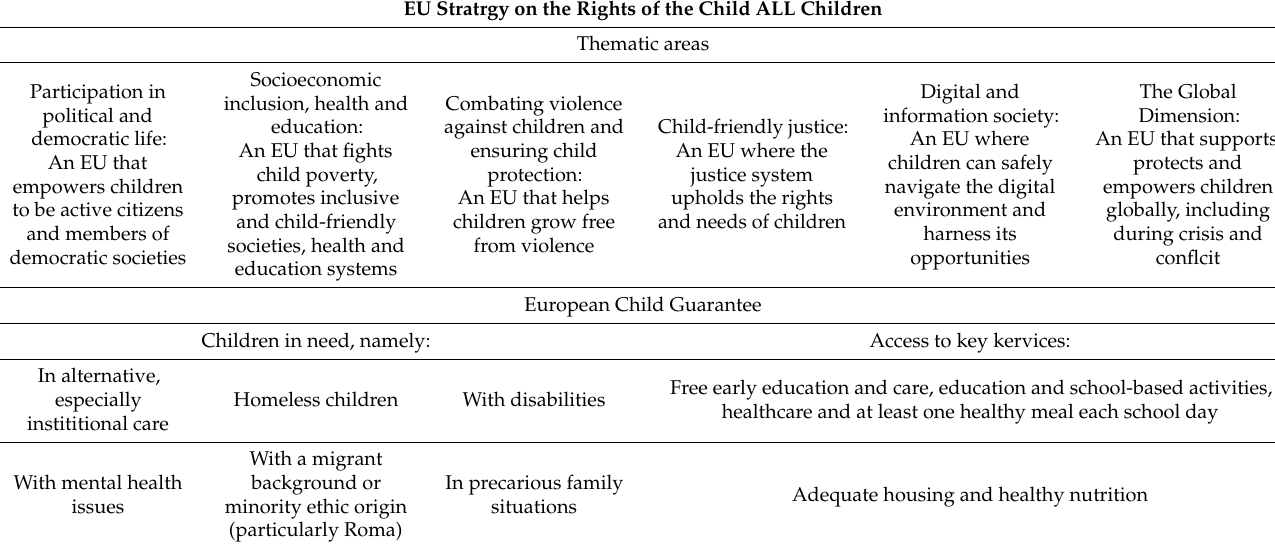
Table 2. The EU Strategy on the Rights of the Child’s thematic areas and the European Child Guarantee’s target groups and key services. Source: own